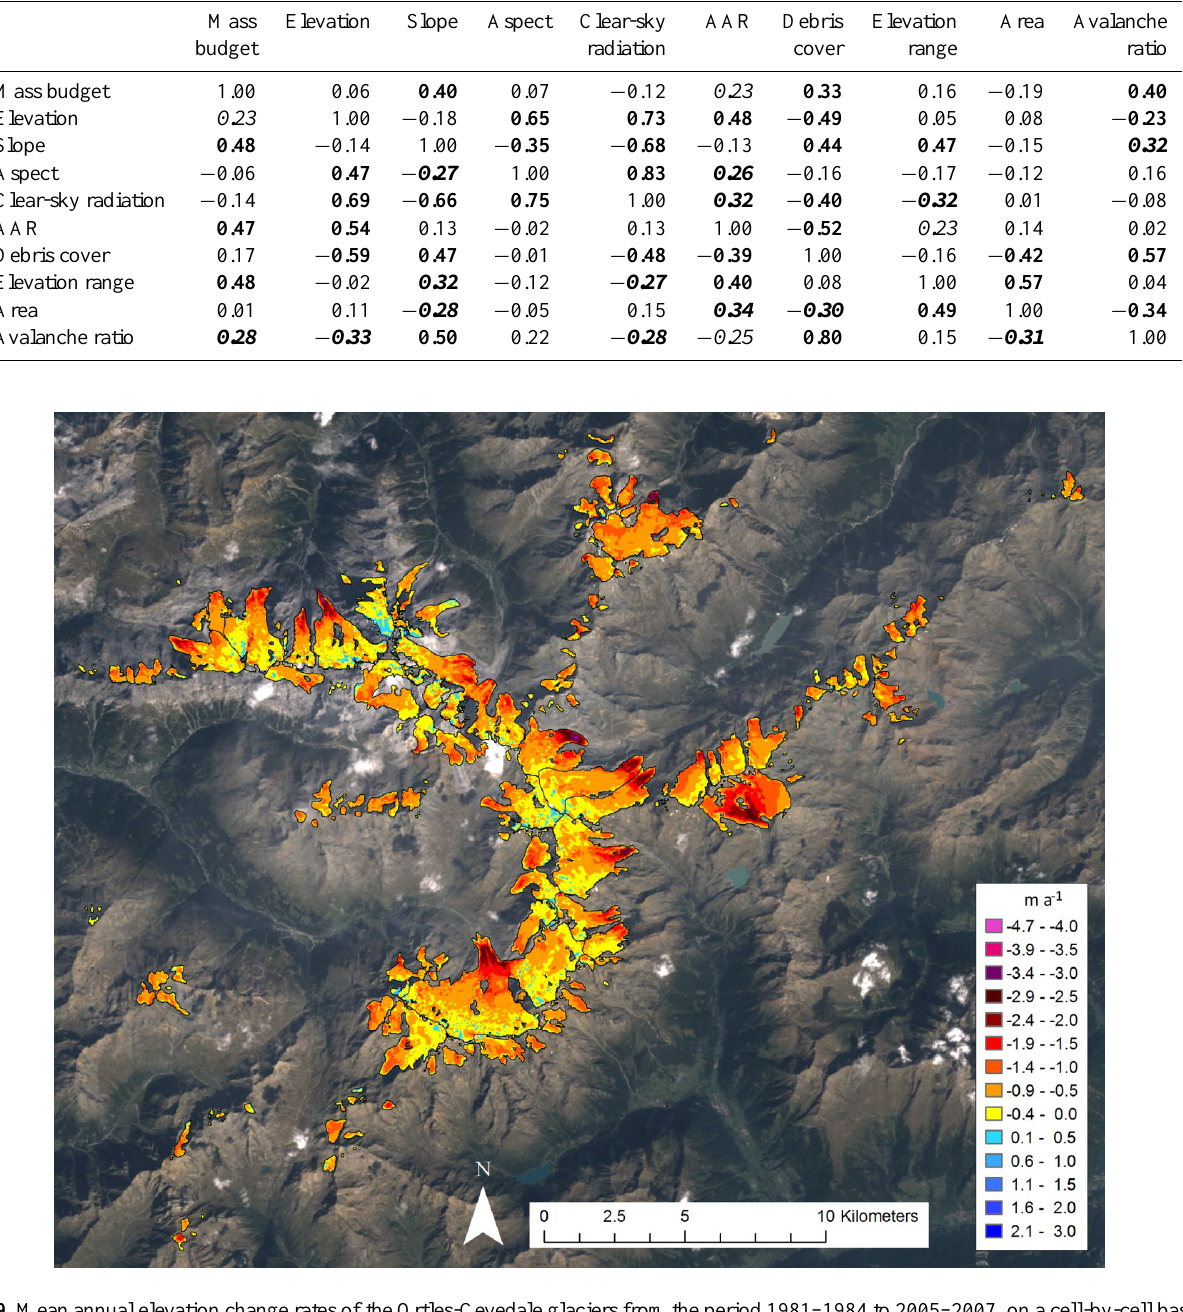
Table 4. Correlation matrix for ten variables. Correlations significant at the 0.01, 0.05 and 0.10 levels are marked in bold type, bold-italic and italic, respectively. Glaciers larger than 0.3km 2 are in the lower left ( n = 51), glaciers smaller than 0.3km 2 are in the upper right ( n = 61).